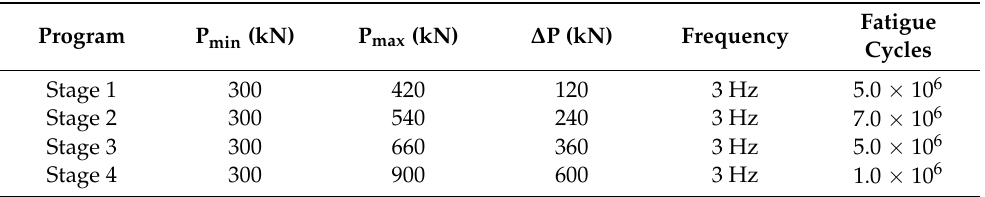
Table 1. The loading parameters of the fatigue test.